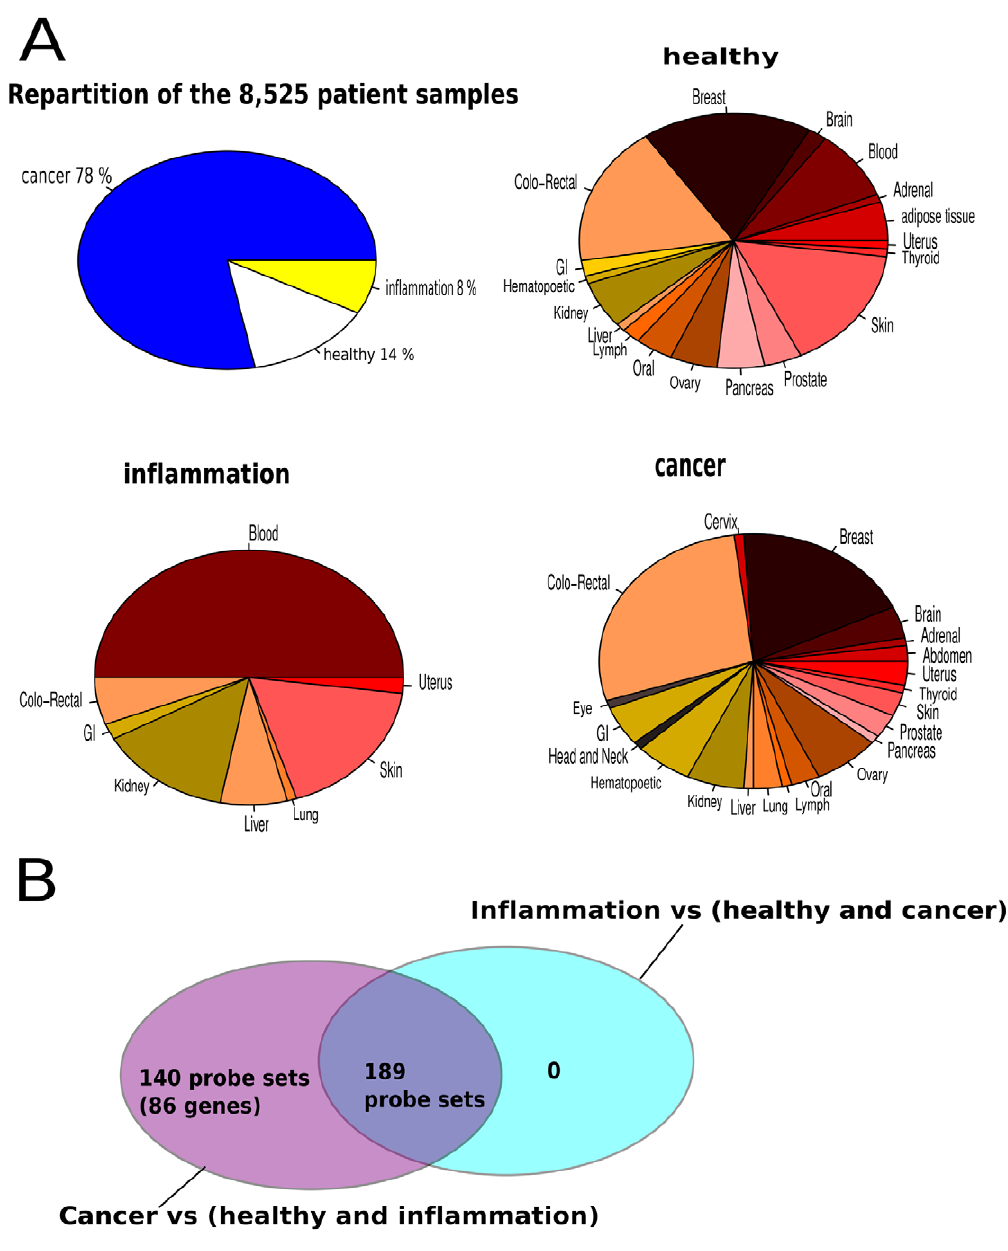
Figure 4. Patient sample repartition and cancer-specific gene expression analysis. Microarray gene expression data representing 8,525 patients samples were downloaded from GEO. A- 78% of patients had different cancer types; 14% are healthy individual and were sampled from different tissues; 8% of patients had inflammation/sepsis and were investigated from the whole blood and other tissues. B- differential expression of the MCN top ten central TFs target gene list coding for secreted and transmembrane proteins were analyzed. Among these genes, as shown in the Venn-diagram, 140 probe sets (86 unique genes) were found to be cancer-specific. GI: Gastro-intestinal.